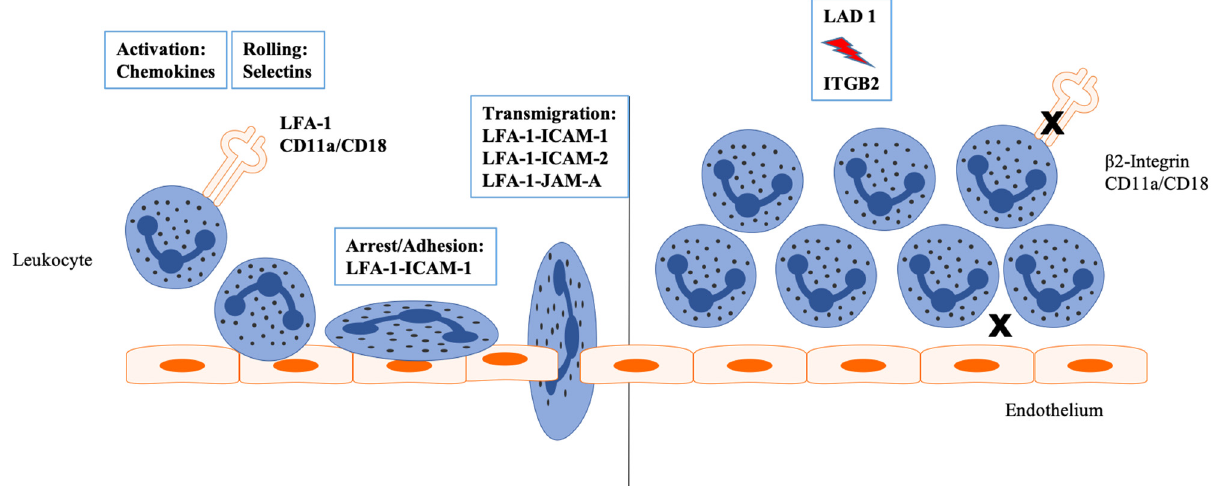
Figure 1. The leukocyte adhesion cascade. Inflammation leads to an activation of the endothelium by endogenous and exogenous stimuli. Selectins, expressed on the surface of activated endothelial cells, mediate rolling of the leukocytes on the luminal surface of the blood vessel. Interactions of the β 2-integrin LFA-1 (lymphocyte function-associated antigen 1) and ICAM-1 and ICAM-2 (intercellular adhesion molecule 1 and 2) enable leukocytes to adhere to the inflamed endothelium. Paracellular and transcellular migration of the leukocytes through the vessel walls is then triggered by ligation of JAM-A (junctional adhesion molecule A), ICAM-1, and ICAM-2. In LAD I, absent or defective expression of β 2-integrins results in an impaired transmigration of leukocytes.